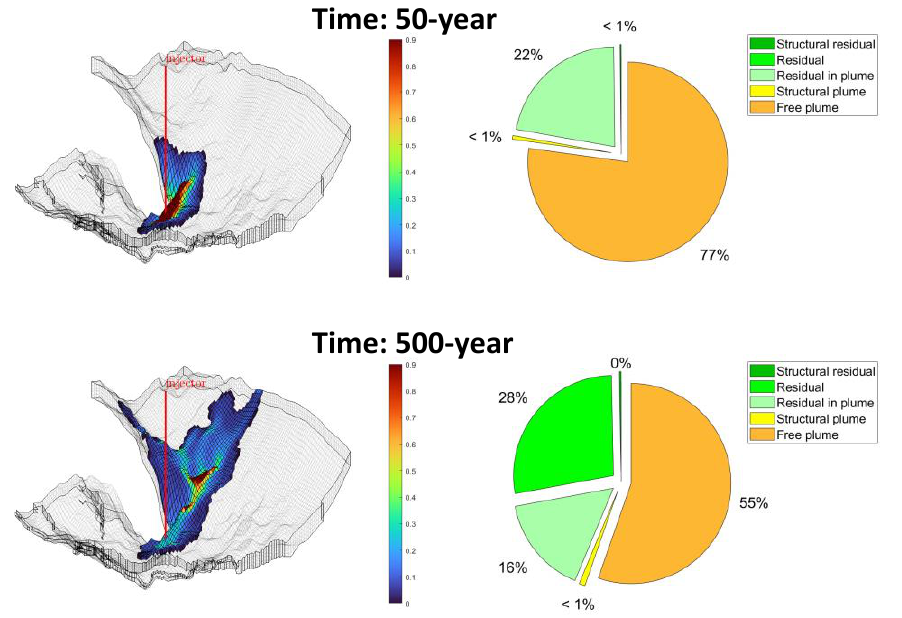
Figure 6. CO 2 saturation profiles and the corresponding trapping inventory diagrams at different times.